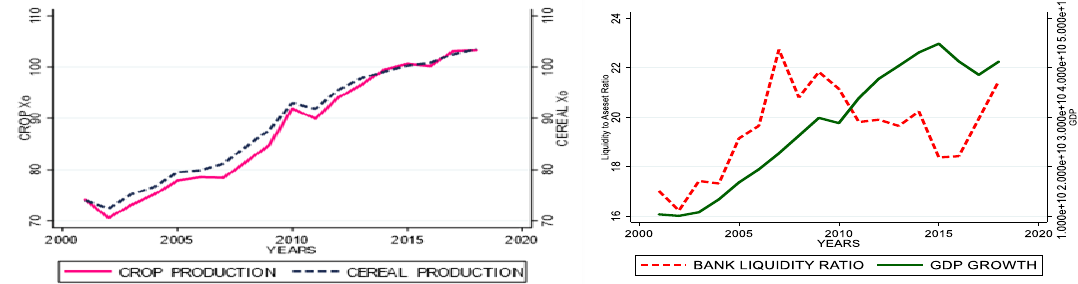
Figure 7: Crop production index versus Cereal production Figure 8: Bank liquidity ratio Vs.